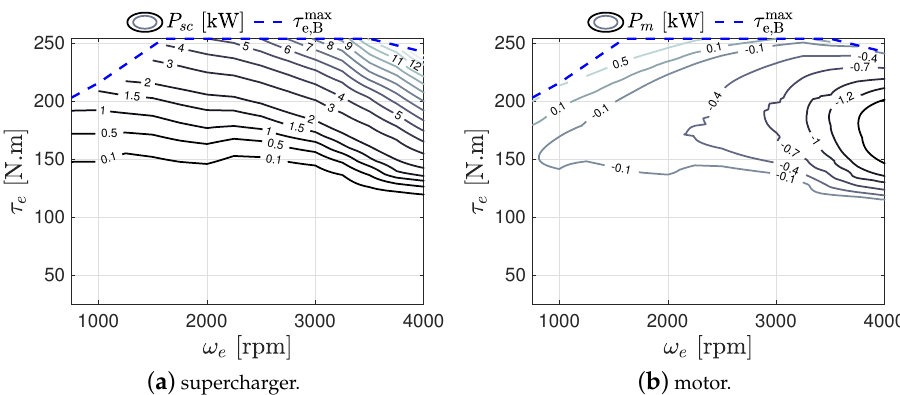
Figure 2. ( a ) Supercharger mechanical power, ( b ) corresponding motor power in the power split supercharger (PSS) system, both for a 1.6 L gasoline engine.